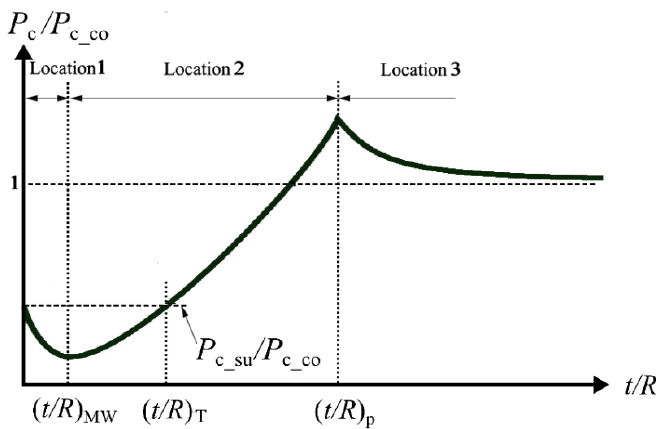
Figure 3. A typical relation between the dimensionless critical contact load P c / P c_co and the dimensionless coating thickness t / R .